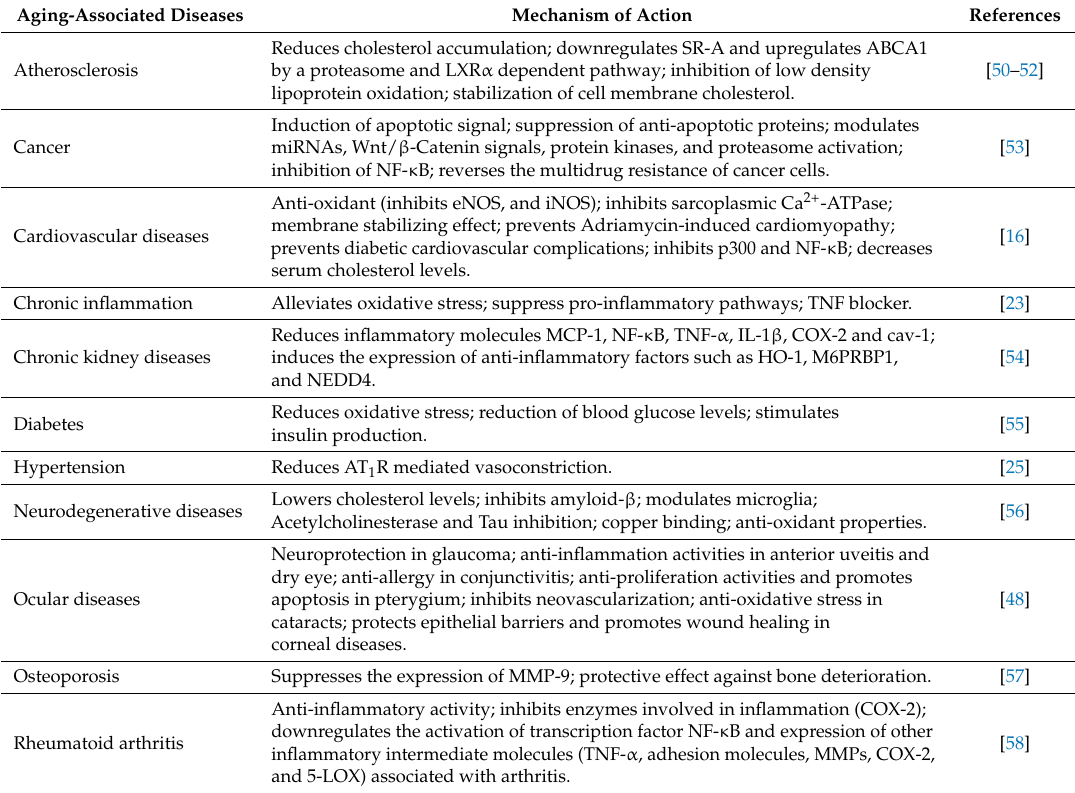
Table 1. Diverse range of mechanisms of action of curcumin in aging-associated